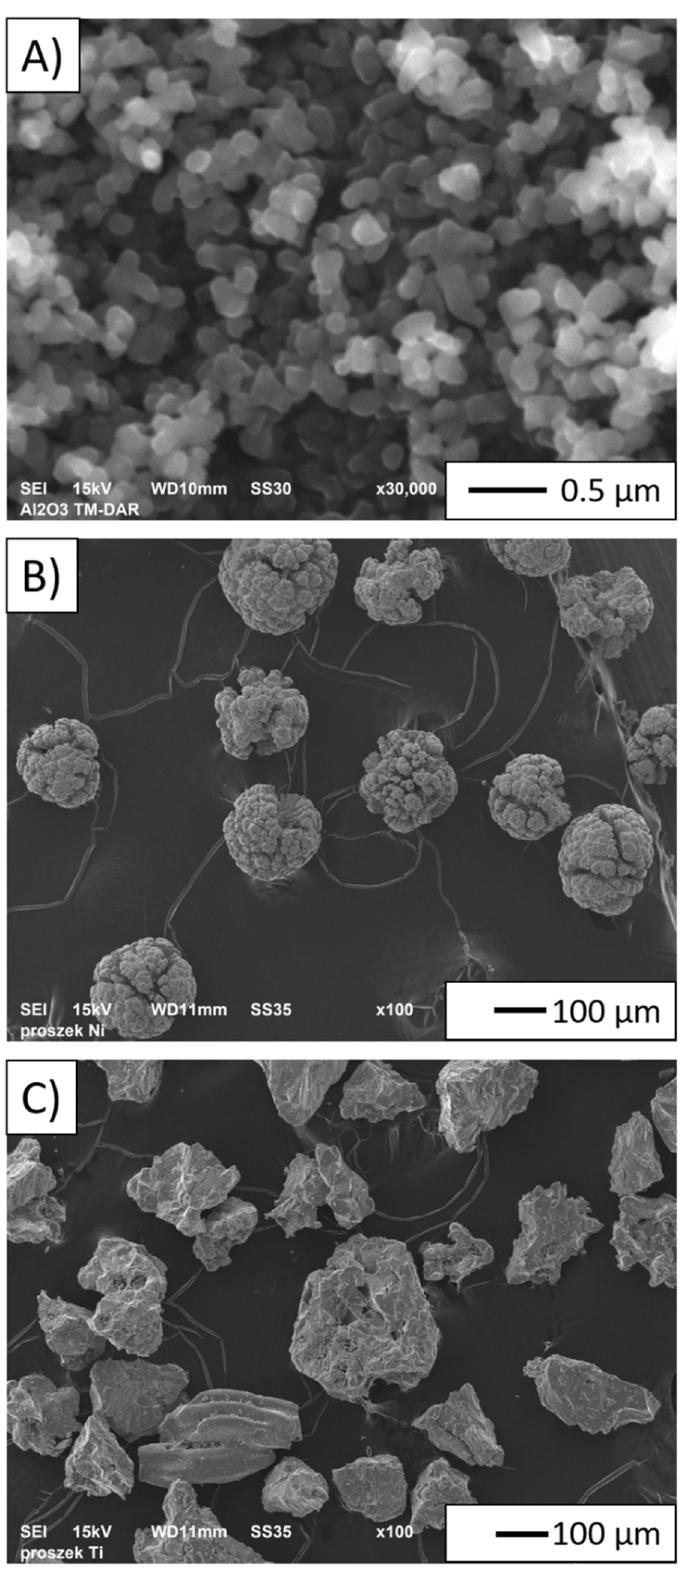
Figure 2. Microstructure of the powders: ( A ) aluminium oxide; ( B ) nickel; ( C ) titanium.